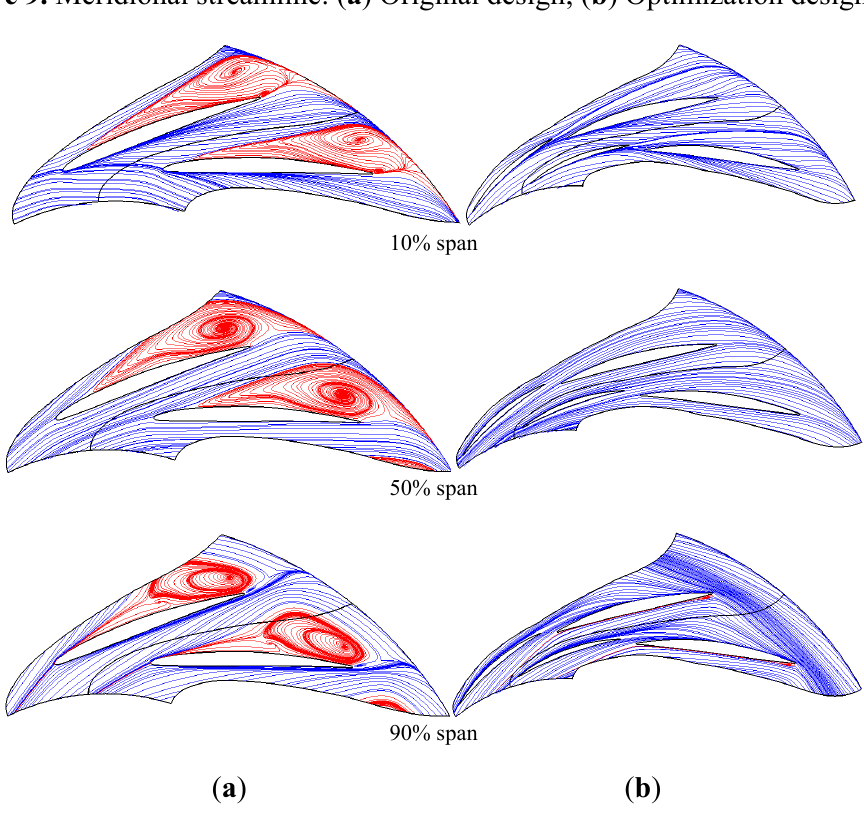
Figure 10. Streamline in the vaned diffuser at different span: ( a ) Original design; ( b ) Optimization design